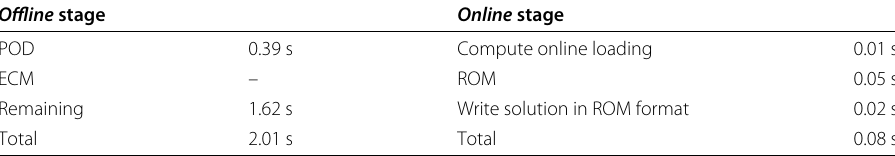
Table 1 Simple test case with convection only using Z-set (durations for the offline and online